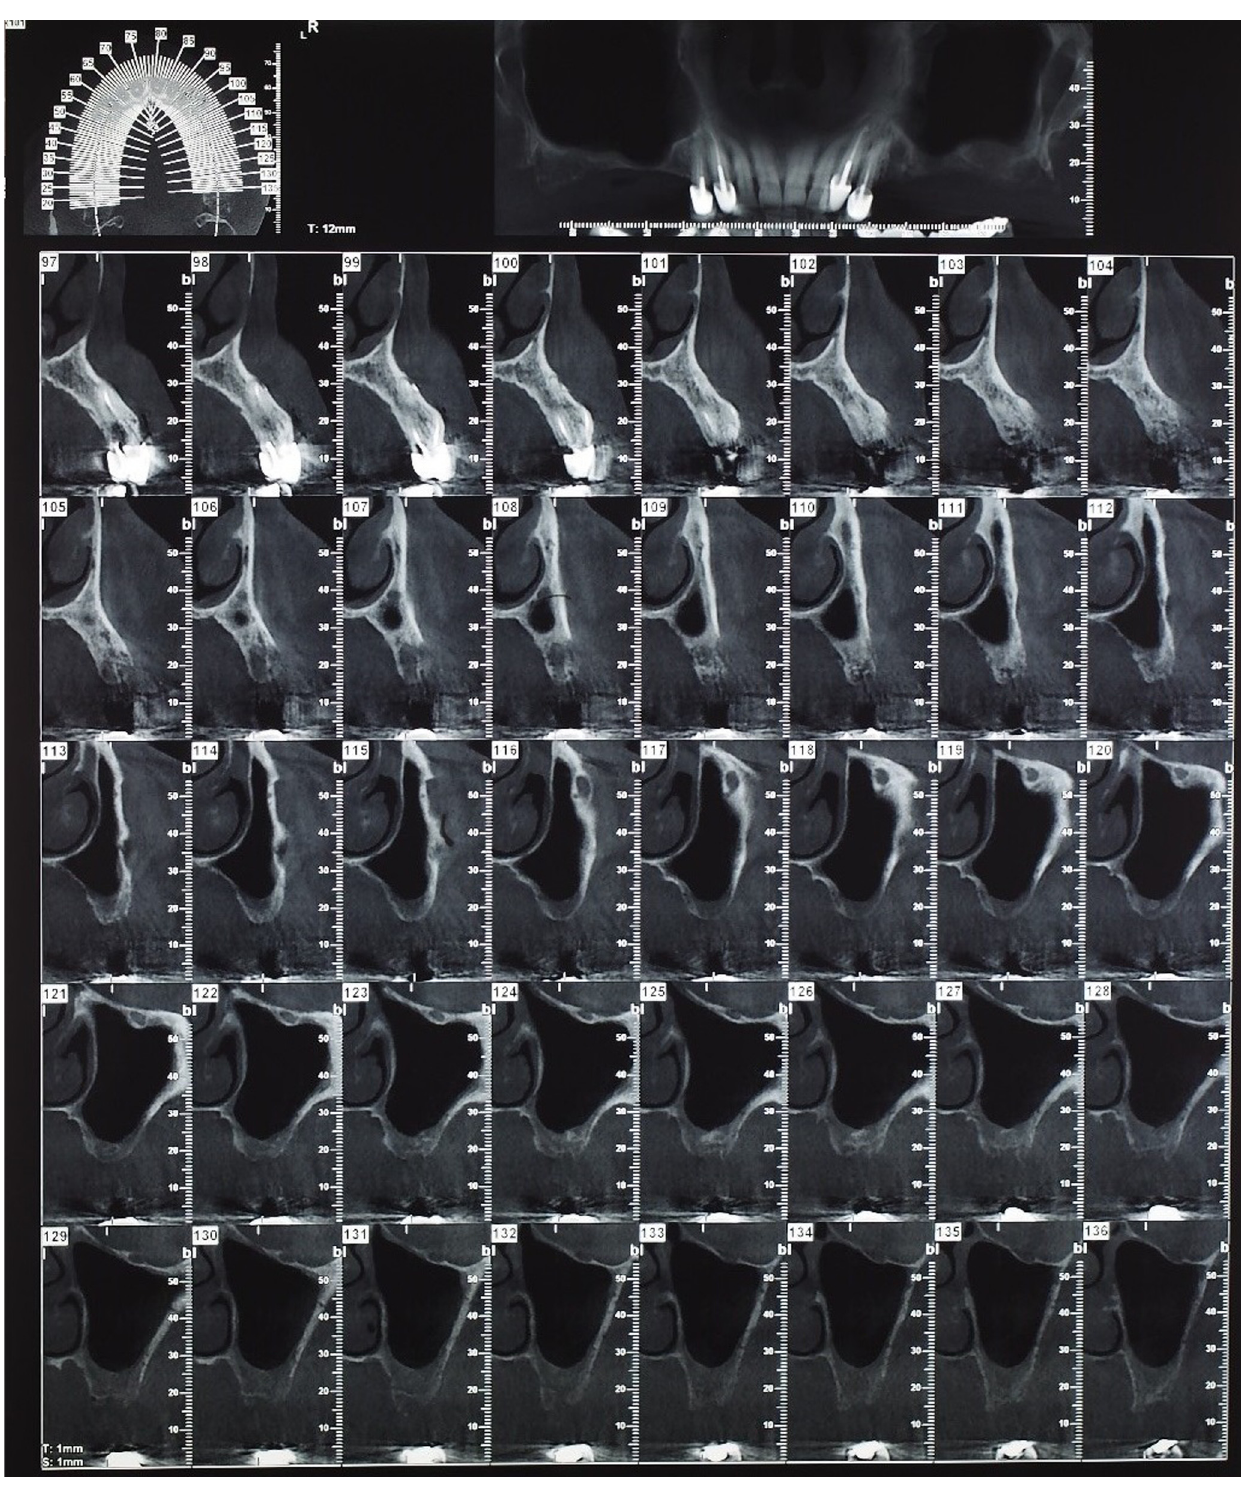
Fig. 5. CBCT at 12 weeks